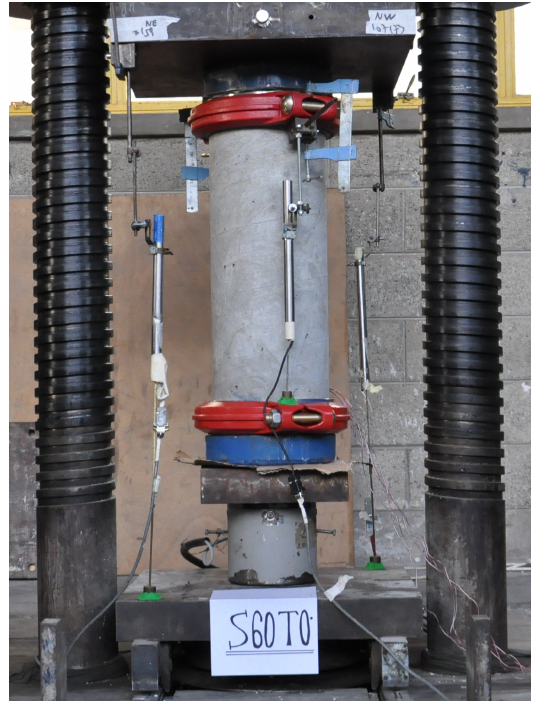
Figure 3. Test setup.